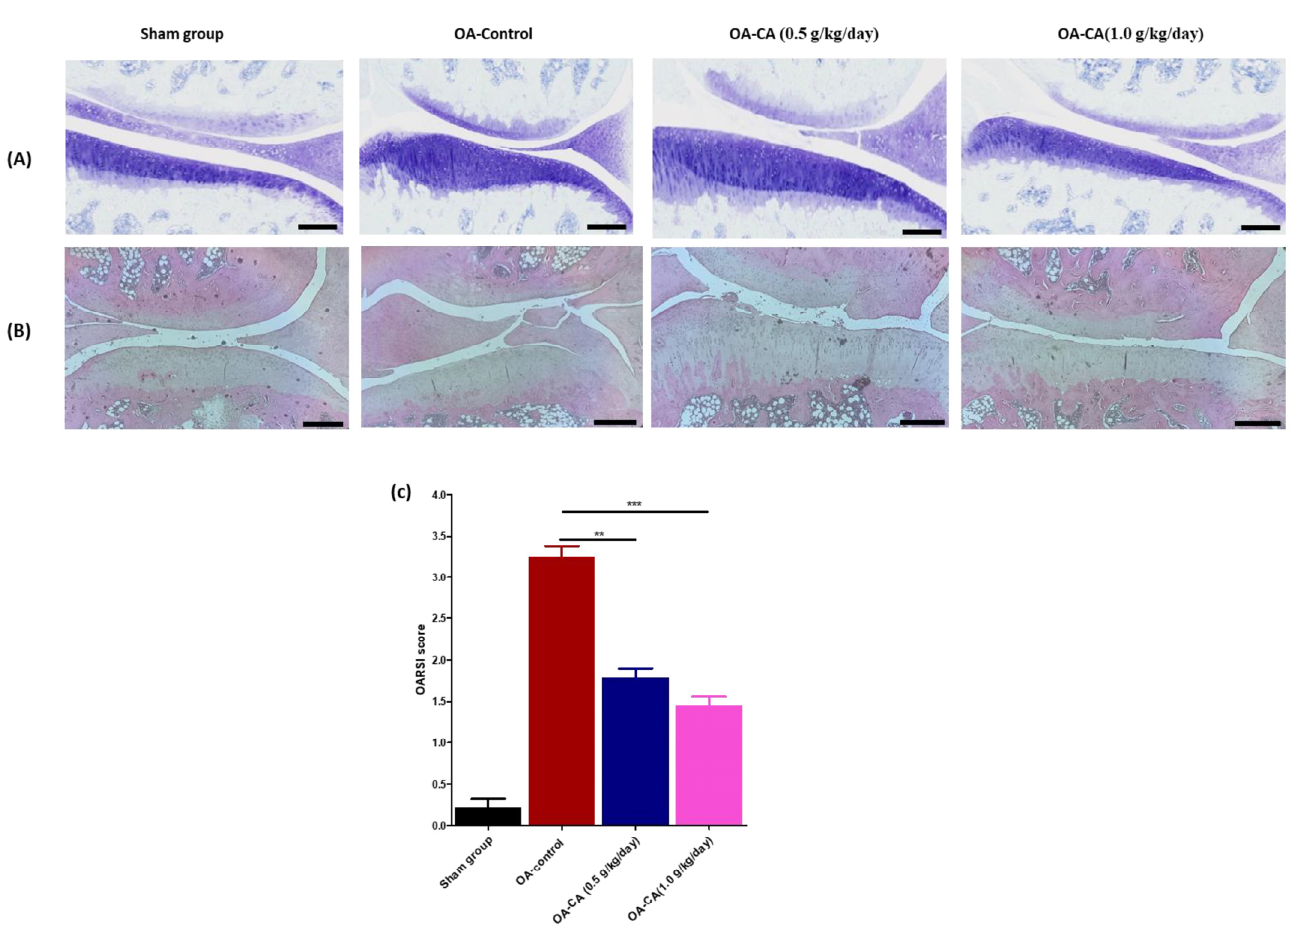
Figure 5. The effects of CA on histological changes and photographical representation of ( A ) toluidine blue, ( B ) H and E assay, and ( C ) calculations of OARSI scores of the sham group, OA-control, and OA-CA treated groups, scale bar = 200 µ M. Experiment data expressed as mean ± S.D. ** p < 0.01, and *** p < 0.001. Table 2. Detection of histopathology changes in the sham group, and OA-control group, OA-CA treated group animals. Histopathology changes were examined from the H and E staining samples from all group animals. Data expressed as mean ± S.D. * p < 0.05, ** p < 0.01, and *** p <